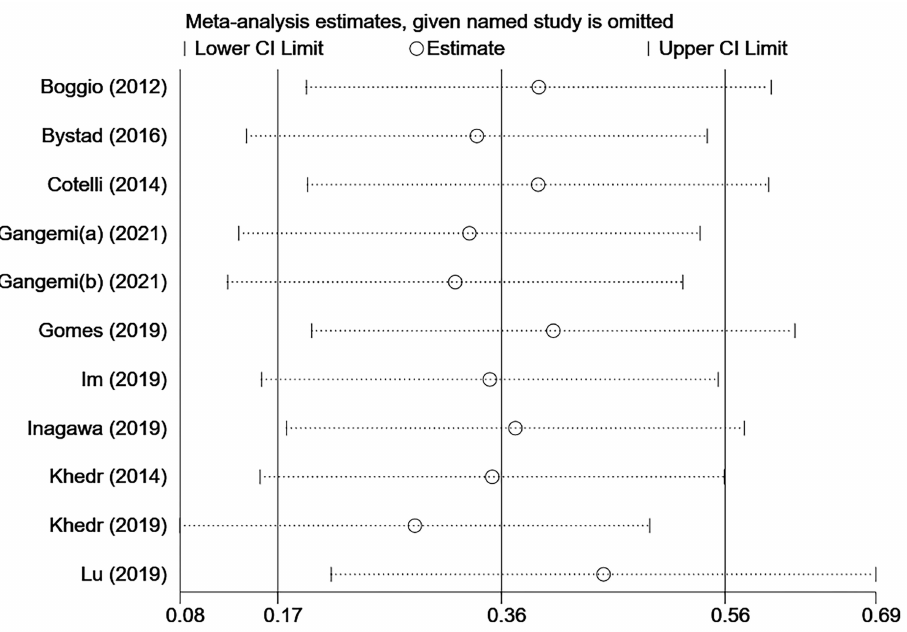
Figure 4. Sensitivity analyses of MMSE. The order of references is [37,38,40,40–46,51].